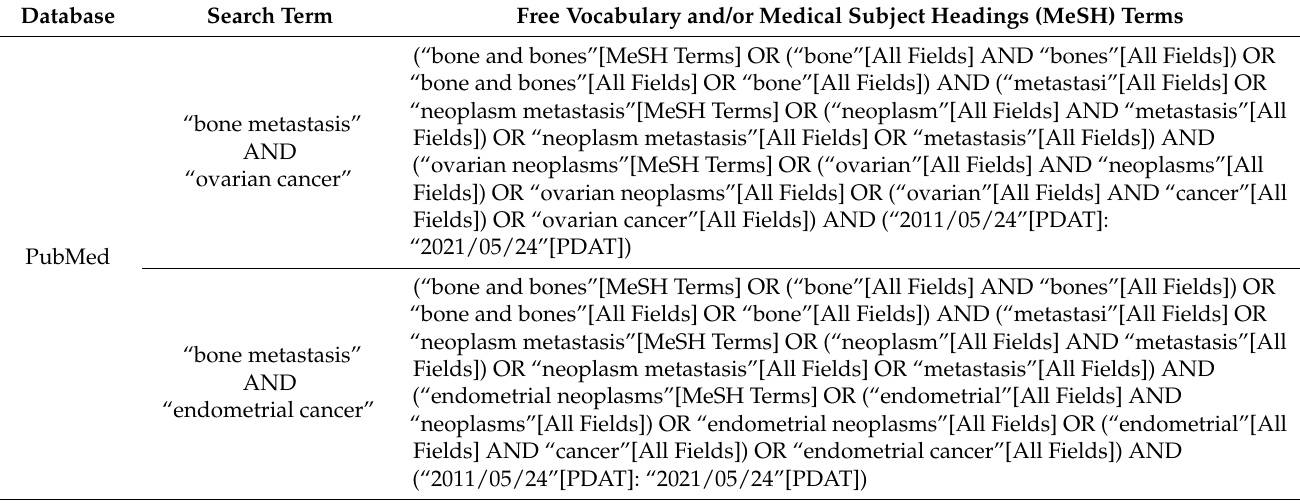
Table 5. Search terms used for PubMed, Scopus, Web of Science Core Collection, and